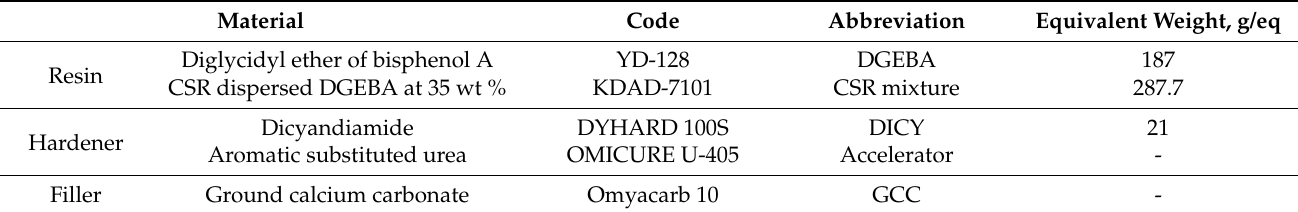
Table 1. Components of structural